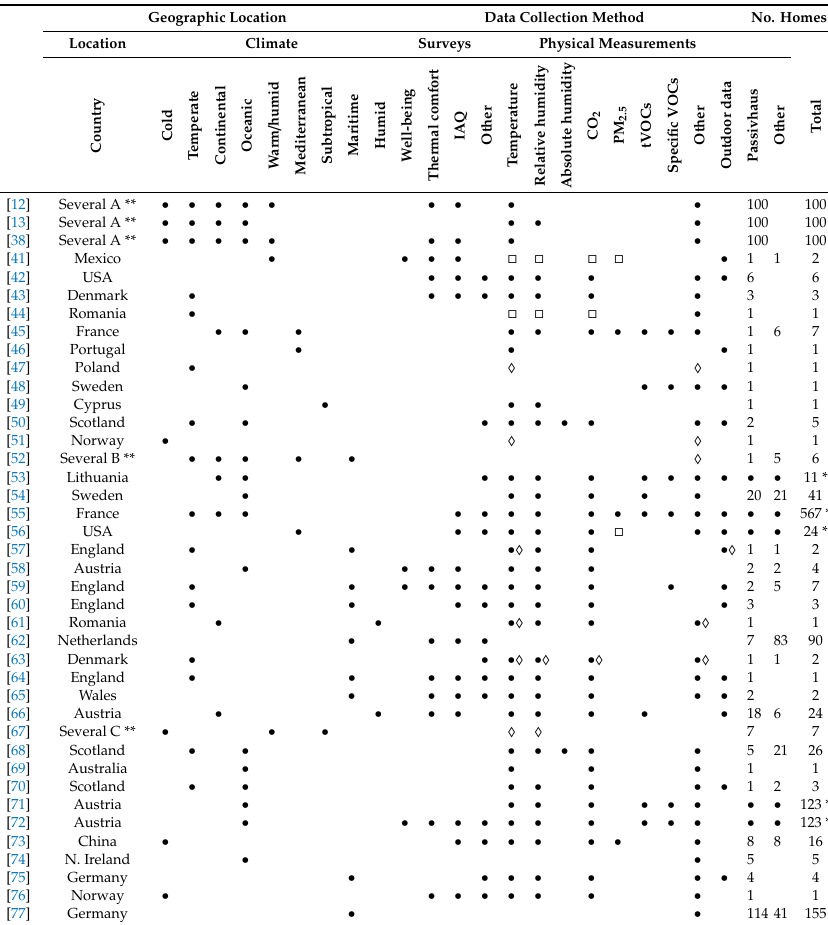
Table 2. Publications about IAQ in Passivhaus dwellings. Part